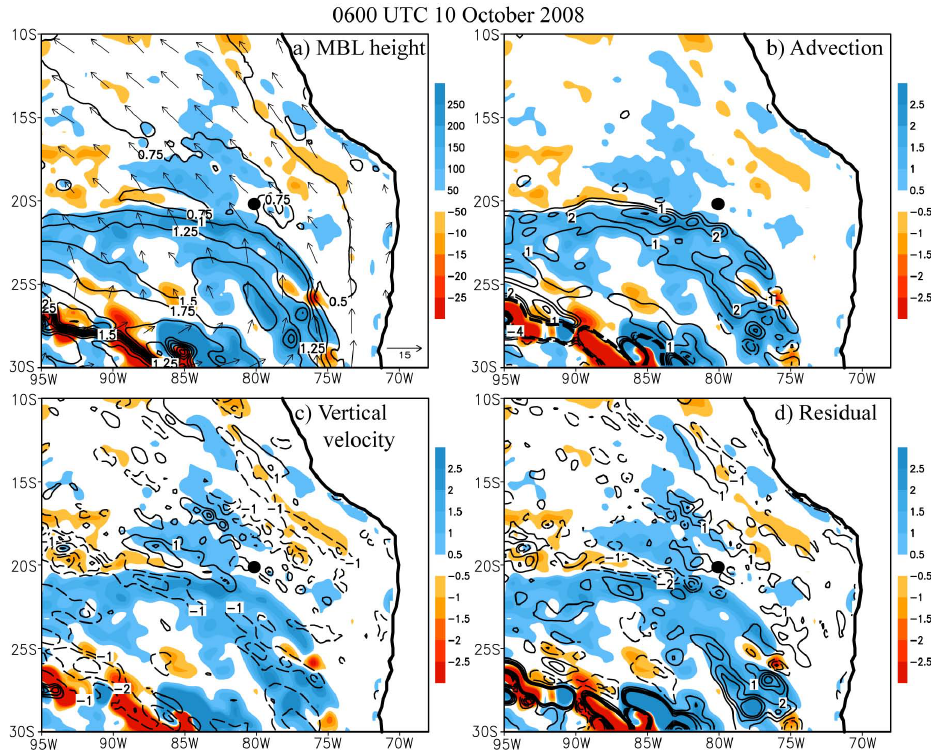
Fig. 10. On 06:00UTC 10 October (a) WRF-simulated MBL depth (km, contours) and three-hour change of MBL depth (m, color), (b) advection (cms − 1 , contour) and ∂H/∂t (cms − 1 , color), (c) vertical velocity (cms − 1 ) and ∂H/∂t (cms − 1 , color), and (d) residual (cms − 1 , contour) and ∂H/∂t (cms − 1 ,